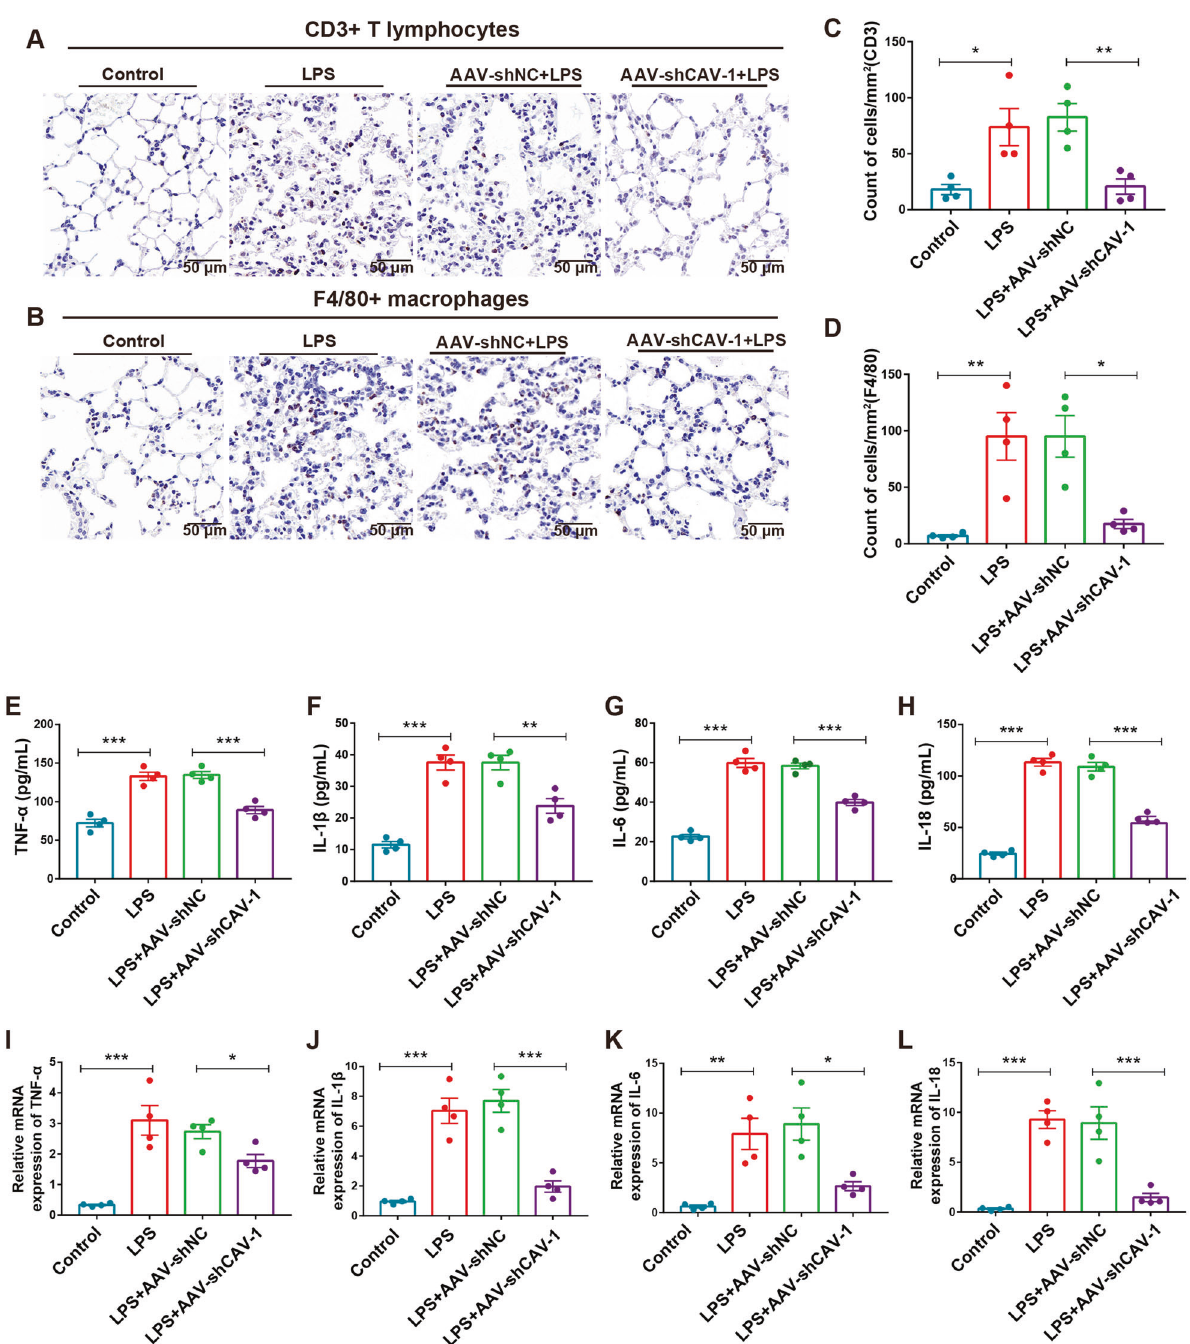
Fig. 5 Knockdown of CAV-1 could reduce the in fi ltration of CD3 + T cells and F4/80 + macrophages and inhibit proin fl ammatory cytokines. A , C The expression of CD3 protein in T cells was detected by immunohistochemistry and the quanti fi cation of CD3 + T cells. B , D The protein levels of F4/80 was determined by IHC and quanti fi cation of F4/80 + cells. Scale bar = 50 μ m. E – H The secretion of TNF- α , IL- 1 β , IL-6, and IL-18 in serum were determined by ELISA. I – L qRT-PCR analysis of TNF- α , IL-1 β , IL-6, and IL-18 in lung tissues. Results were represented as mean ± SEM ( n = 4, * p < 0.05, ** p < 0.01, *** p <